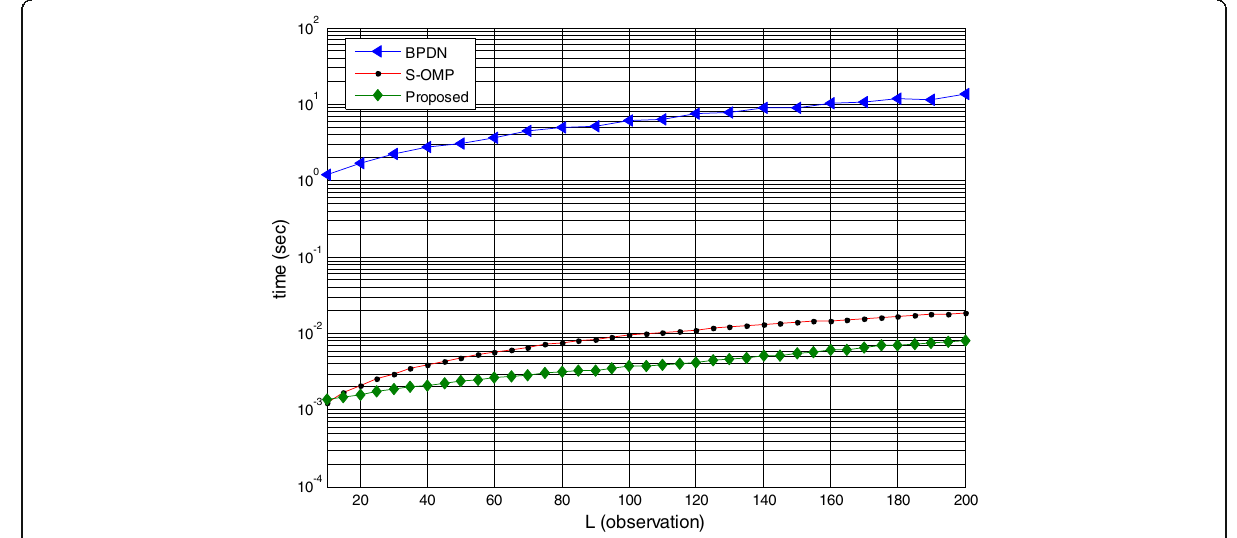
Fig. 5 Running time as a function of number of